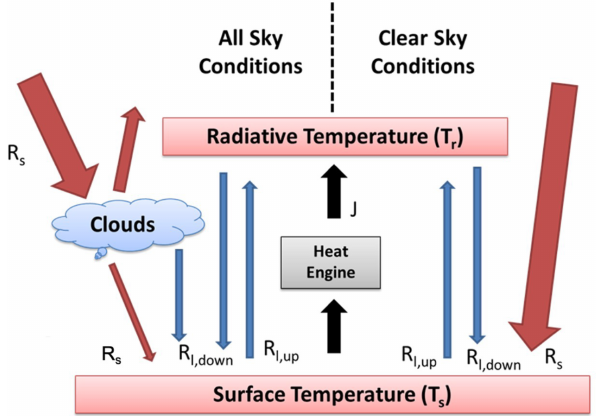
Figure 1. Schematic diagram of the surface energy balance, the fluxes of solar (red) and terrestrial (blue) radiation, as well as the turbulent heat fluxes (black). We consider turbulent heat exchange being driven primarily by an atmospheric heat engine that operates at the thermodynamic limit of maximum